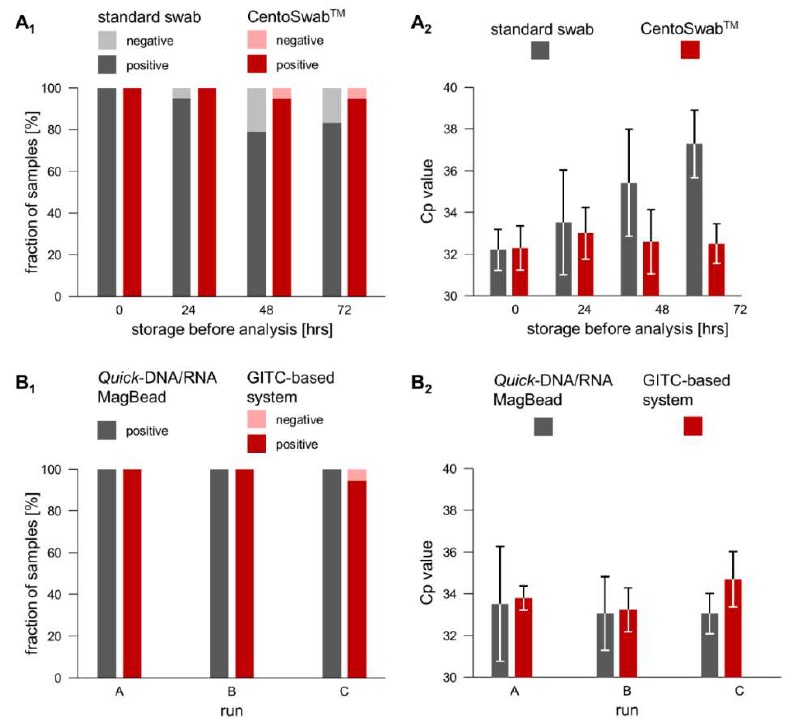
Figure 1. Comparative validation of options for sample collection and for RNA extraction. ( A ) RNA stability on a standard buccal swab vs. on CentoSwab TM was compared regarding the fraction of samples testing positive ( A 1 ), and the number of RT-PCR cycles required to reach the signal threshold in RT-PCR (Cp value) ( A 2 ). ( B ) The ability to extract analyzable RNA was compared between a commercially available system and the in-house-developed regarding the GITC-based system in three independent runs (termed A, B, and C). Parameters used for comparison were the fraction of samples testing positive ( B 1 ), and the number of RT-PCR cycles required to reach the signal threshold in RT- PCR (Cp value) ( B 2 ).